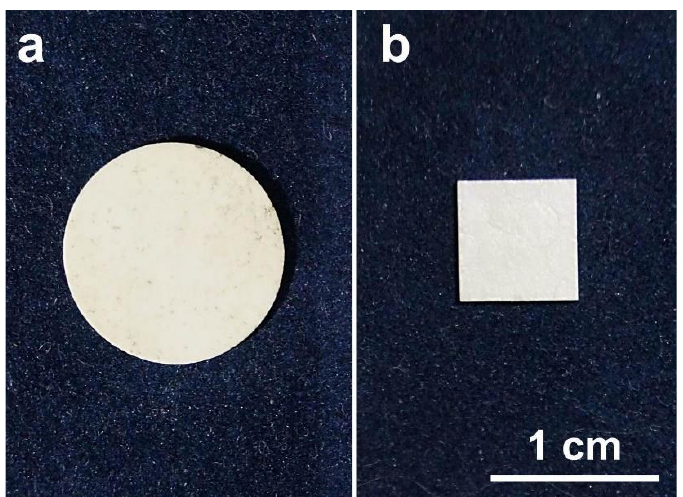
Figure 1. (ZrO 2 ) 0.909 (Y 2 O 3 ) 0.09 (Eu 2 O 3 ) 0.001 ceramic specimens synthesized from crushed single crystals of similar composition using ( a ) uniaxial compaction and ( b ) slip casting.